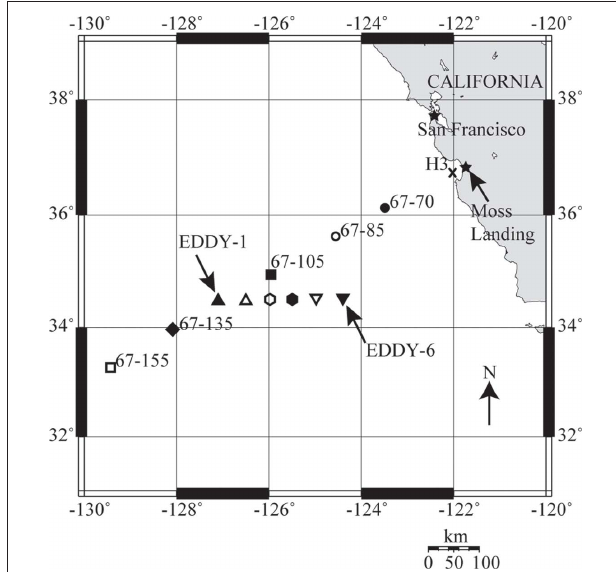
FiguRe 1 | A map of nucleic acid sampling stations on cruise CN207, which follow CalCOFi line 67. The coastal-upwelling zone station H3 is marked by an X, coastal-transition zone stations 67–70 and 67–85 are marked with solid and hollow circles, core California Current (CC) station 67–105 is marked by a solid square, CC transition station 67–135 is marked with a solid diamond and oligotrophic open-ocean station 67–155 is marked with a hollow square. Upward and downward triangles and hexagons mark individual cyclonic eddy stations. The map was generated using OMC (http://www.